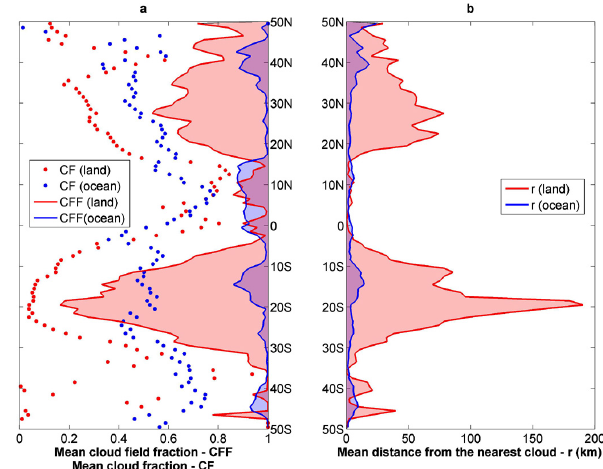
Fig. 4. Latitudinal mean cloud fraction (left panel, dots), cloud field fraction (left panel, lines) and distance from the nearest cloud (right panel), above land (red) and ocean (blue), based on MODIS Terra observations for 28 July